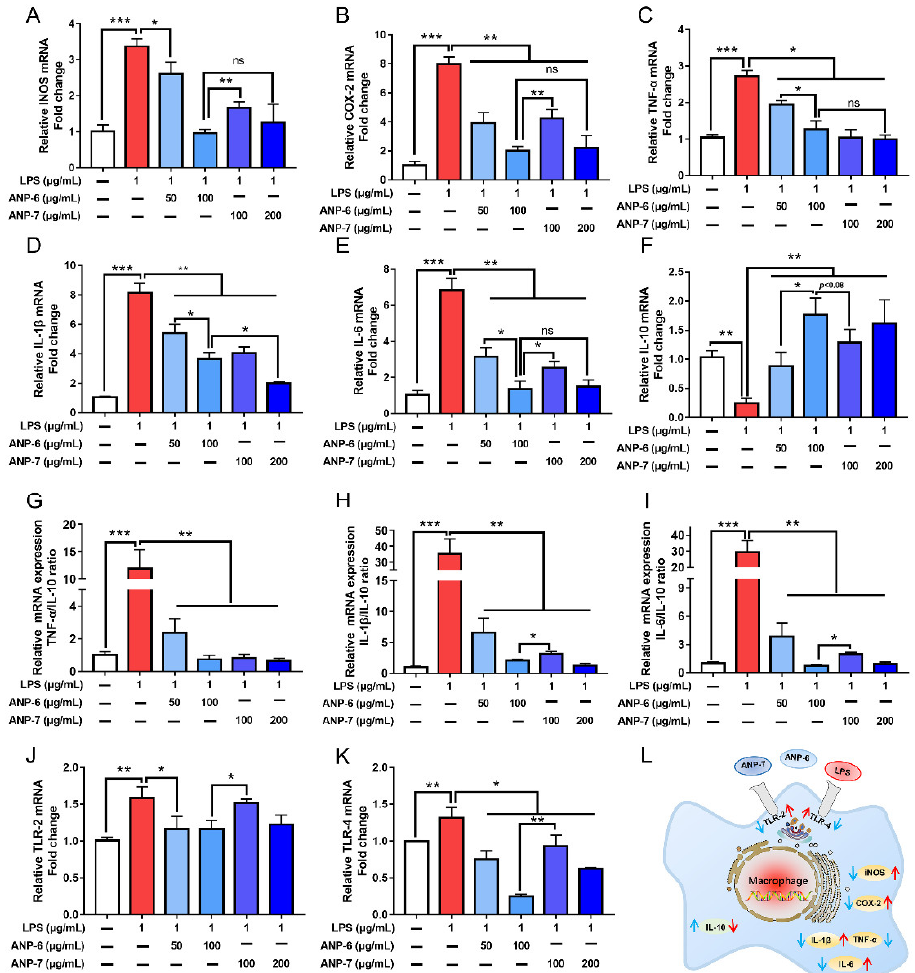
Figure 7. Effects of ANP-6 and ANP-7 on mRNA levels of iNOS ( A ), COX-2 ( B ), TNF-α ( C ), IL-1β ( D ), IL-6 ( E ), IL-10 ( F ), TNF-α/IL-10 ratio ( G ), IL-1β/IL-10 ratio ( H ), IL-6/IL-10 ratio ( I ), TLR-2 ( J ), TLR-4 ( K ) and the possible signaling pathways of ANP-6 and ANP-7 ( L ). Results were indicated as the mean ± SD ( n = 3). Values are significantly different from the LPS treated or control group at * p < 0.05, ** p < 0.01, and *** p < 0.001. ns, not